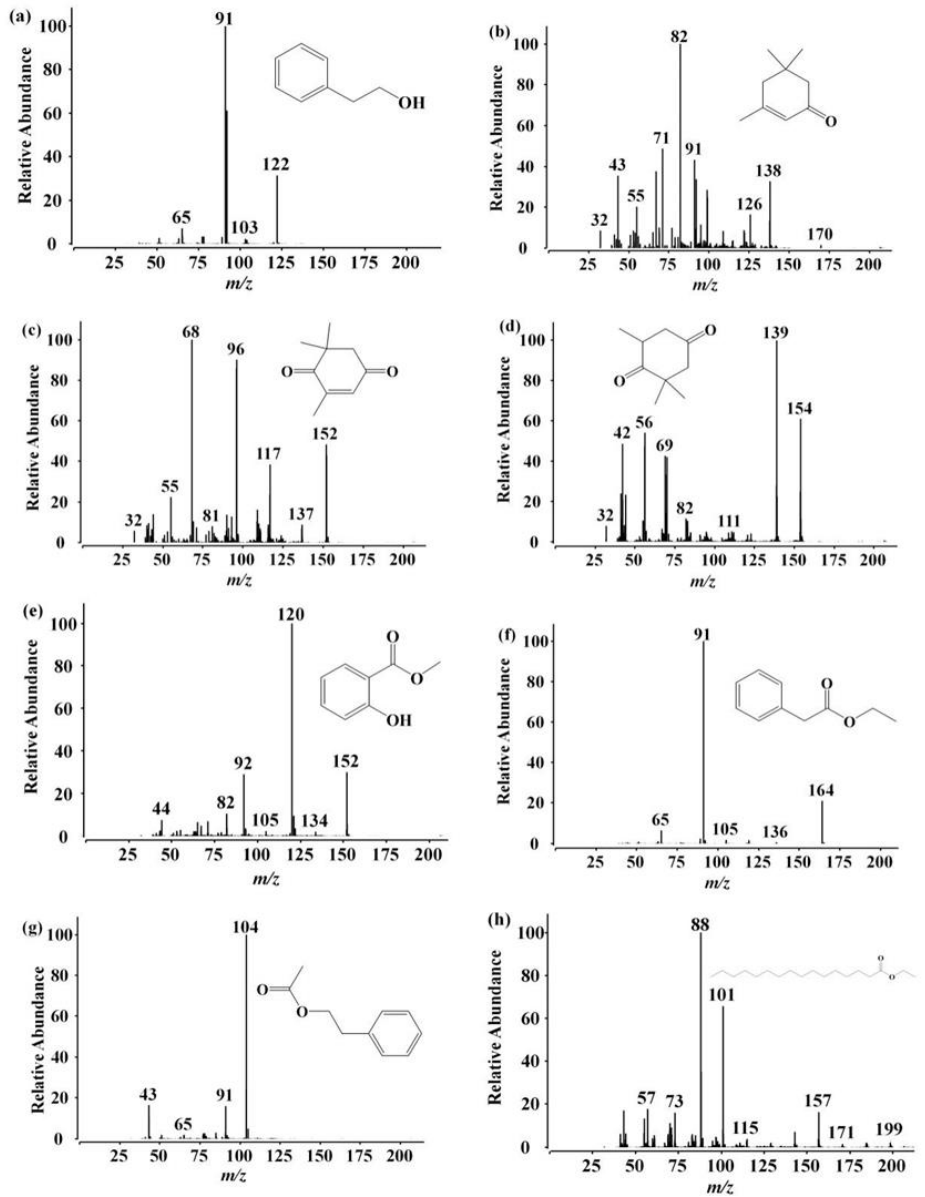
Figure 2. The mass fragments of the 8 potential markers in the ACC (identified in Figure 1A): (a) 2-phenylethanol; (b) isophorone; (c) 4-oxoisophorone; (d) dihydrooxophorone; (e) betula; (f) ethyl phenylacetate; (g) phenethyl acetate; (h) ethyl palmitate. Table 1. Compound type of ACC and AMC detected by SPME-GC-MS.